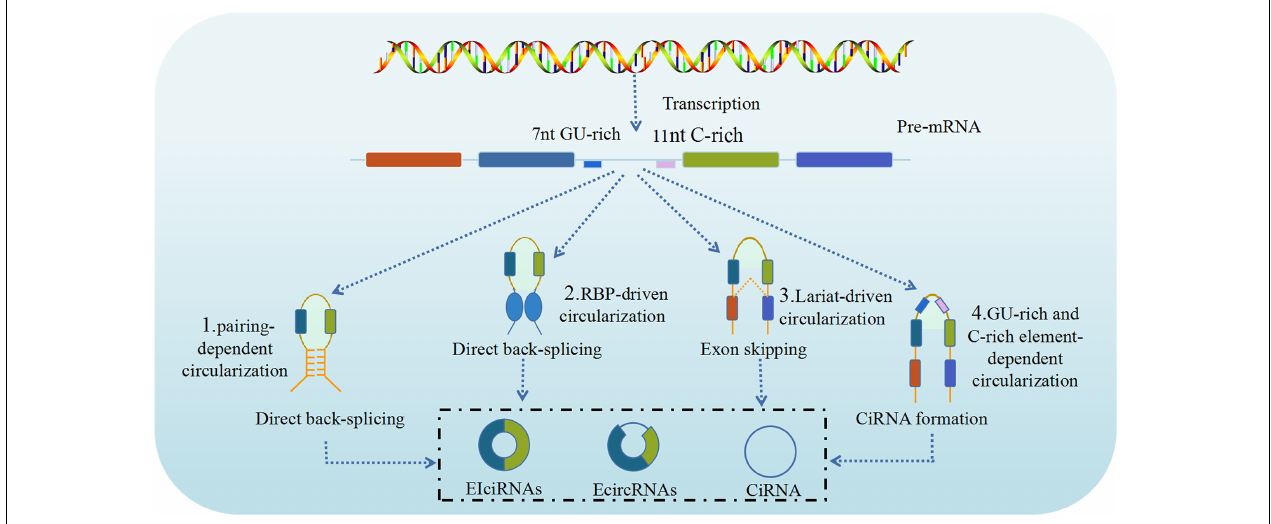
FIGURE 1 | Biogenesis of circRNAs. CircRNAs are generated by back splicing of pre-mRNAs through different pathways (1, 2, 3, 4). CircRNAs can regulate the activities and functions of DNAs, RNAs and proteins in host cells, including: (1) Intron pairing-driven circularization; (2) RNA binding protein (RBP)-driven circularization; (3) Lariat-driven circularization; (4) GU-rich and C-rich element-dependent circularization (Cui et al., 2020).